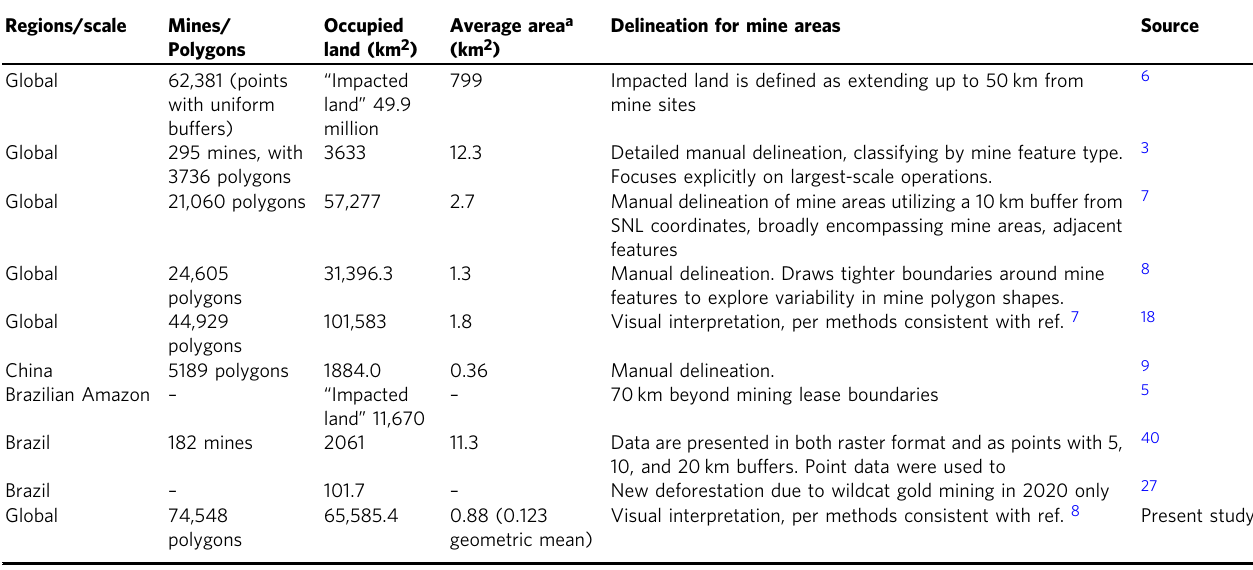
Table 3 Comparison of results with a sample of prior mine area